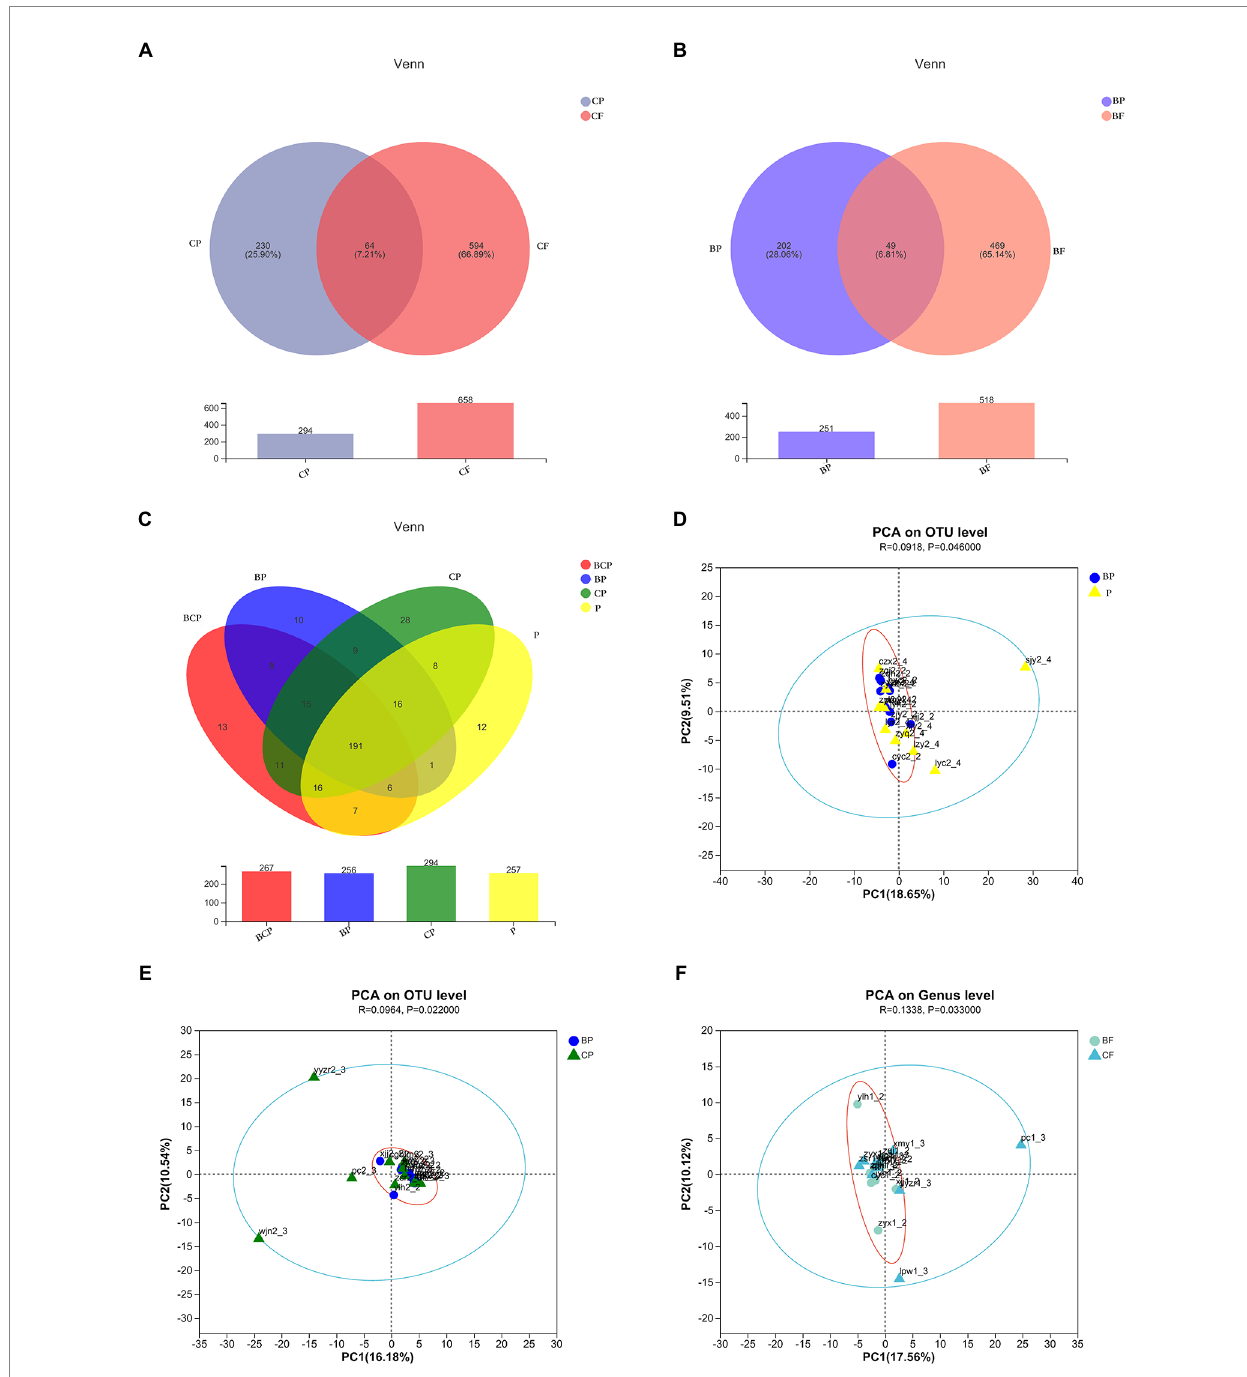
FIGURE 2 Venn diagrams depicting operational taxonomic unit (OTU) distributions in (A) CP and CF groups, (B) BP and BF groups, and (C) all plaque samples. Based on ANOSIM, PCA reveals differences in microbiome-community structures in (D) BP and P, (E) BP and CP, and (F) BF and CF